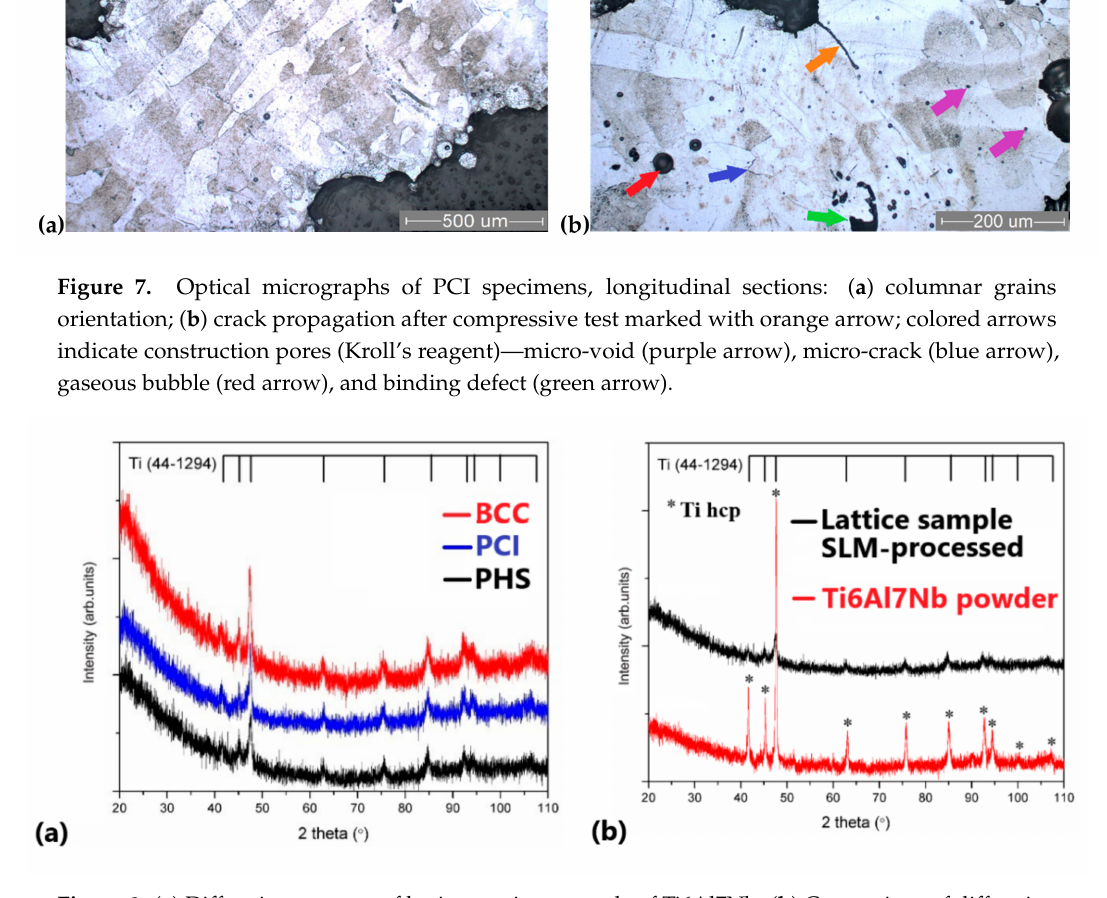
Figure 8. ( a ) Di ff raction patterns of lattice specimens made of Ti6Al7Nb. ( b ) Comparison of di ff raction patterns between raw powder and SLM lattice